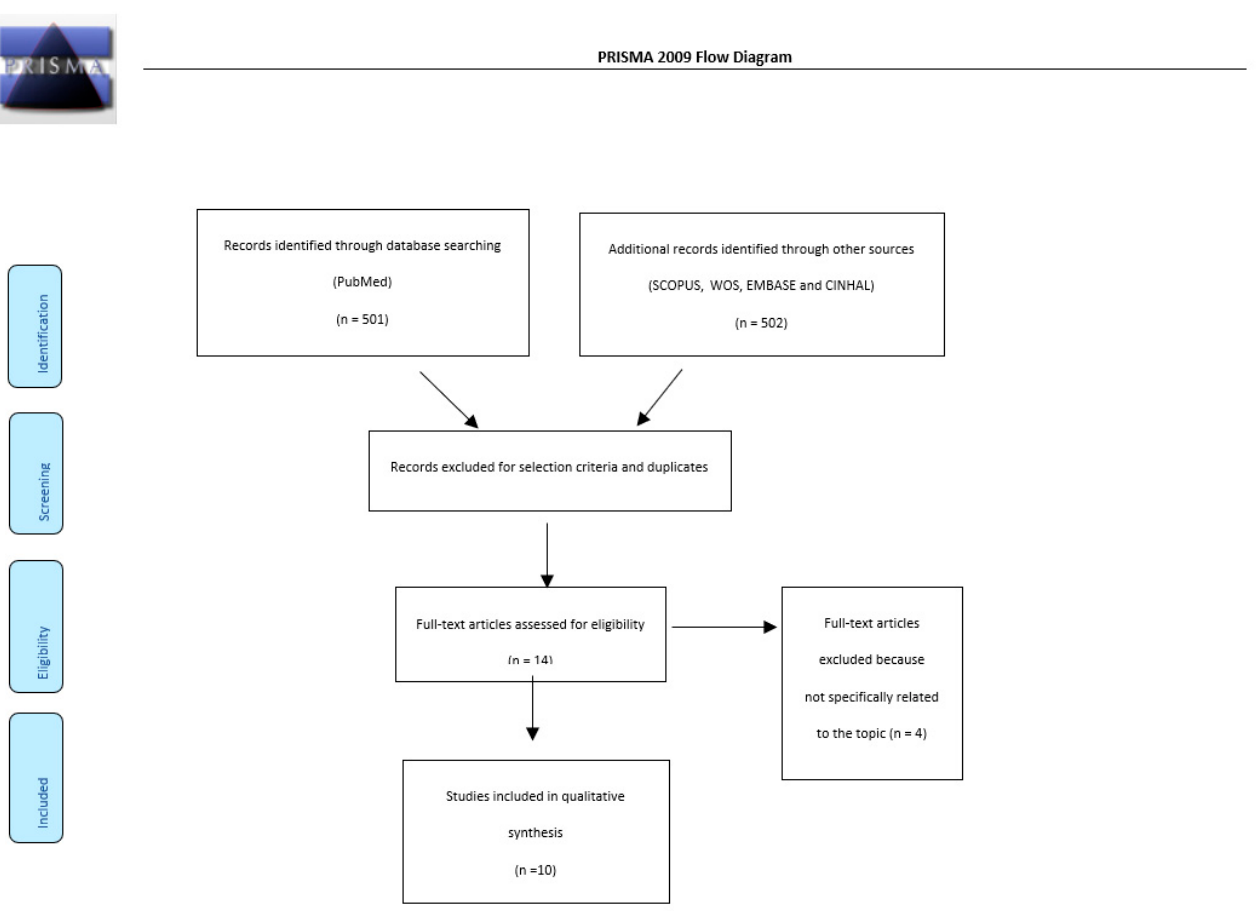
Figure 1. Prisma flow diagram of our review.